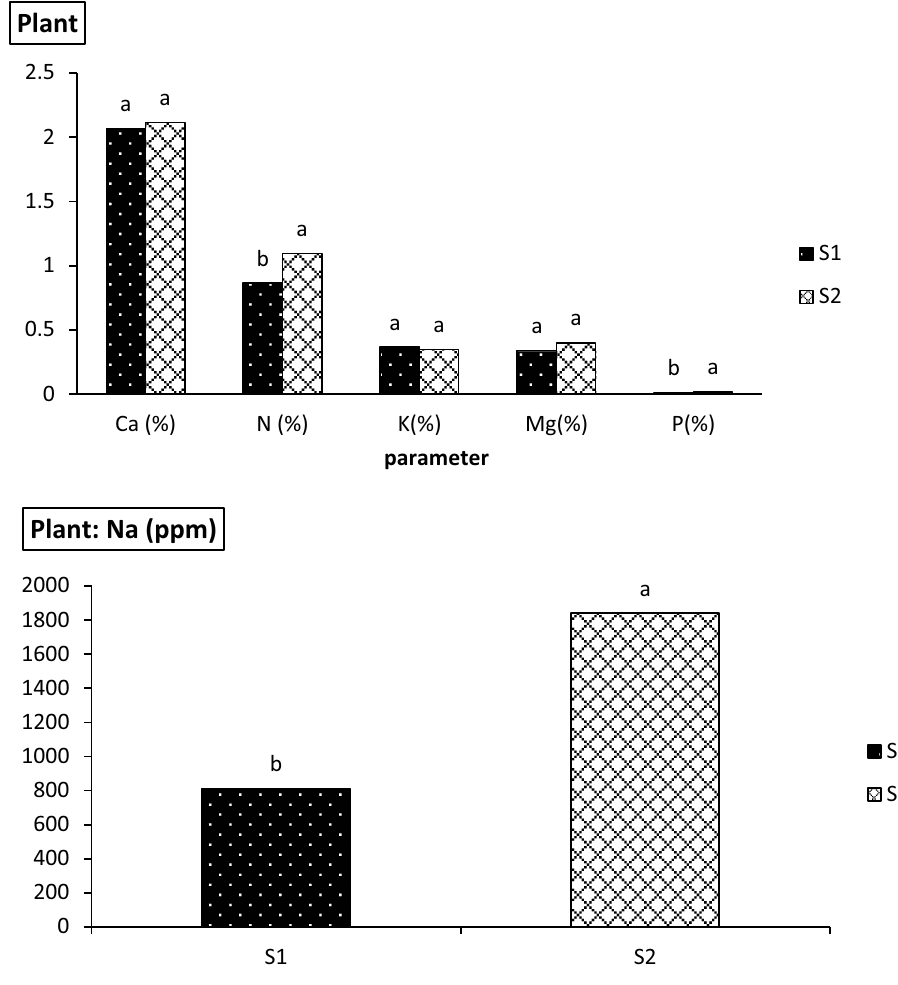
Fig. 8 Effect of volcanic tuff on nutrient contents of